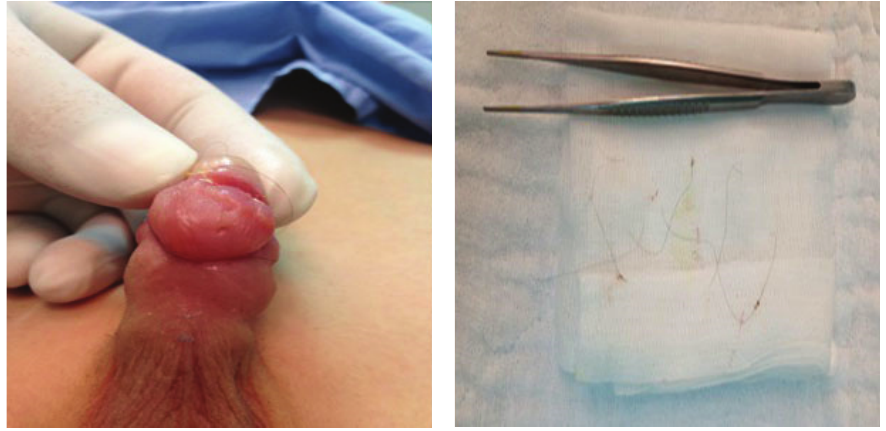
Figure 1: The appearance of penile tourniquet syndrome at the time of diagnosis, and causative factor: hair strand of mother.